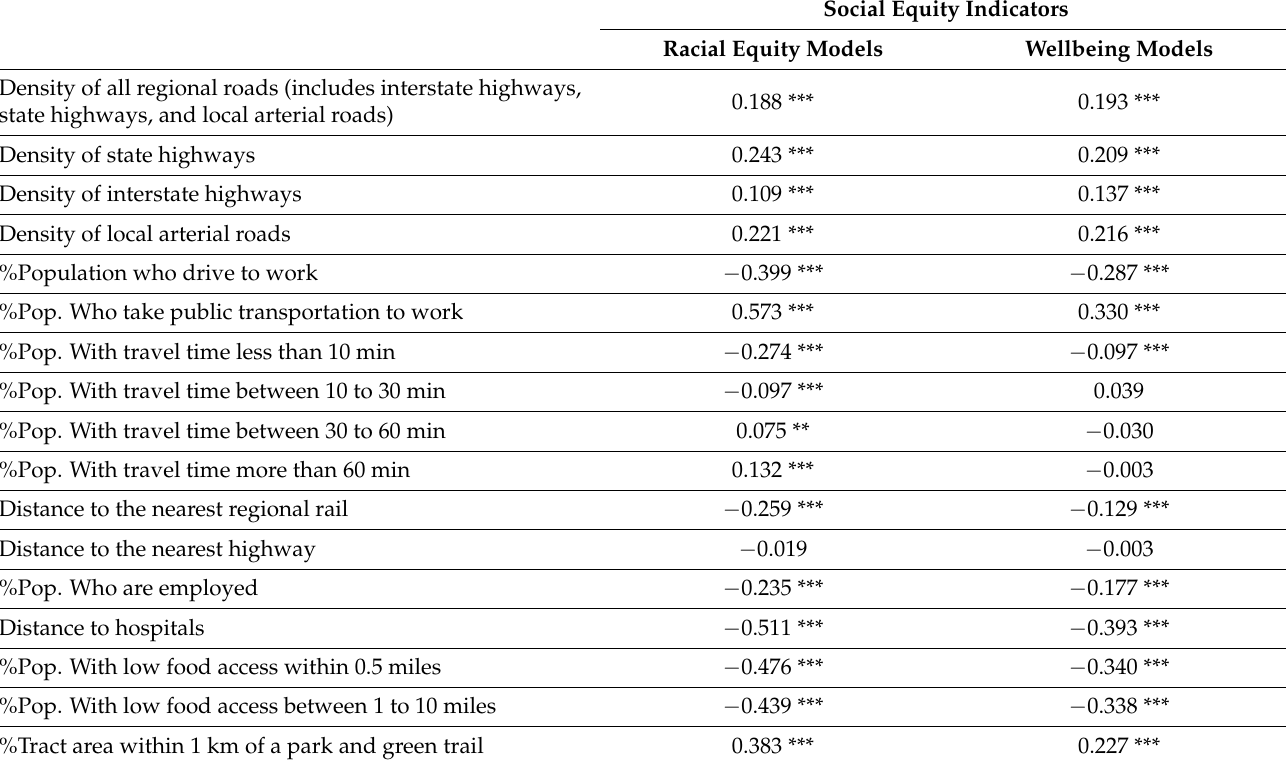
Table 1. Pearson’s correlation r-values between social equity indicators and infrastructure predictors. Social Equity Indicators Racial Equity Models Wellbeing